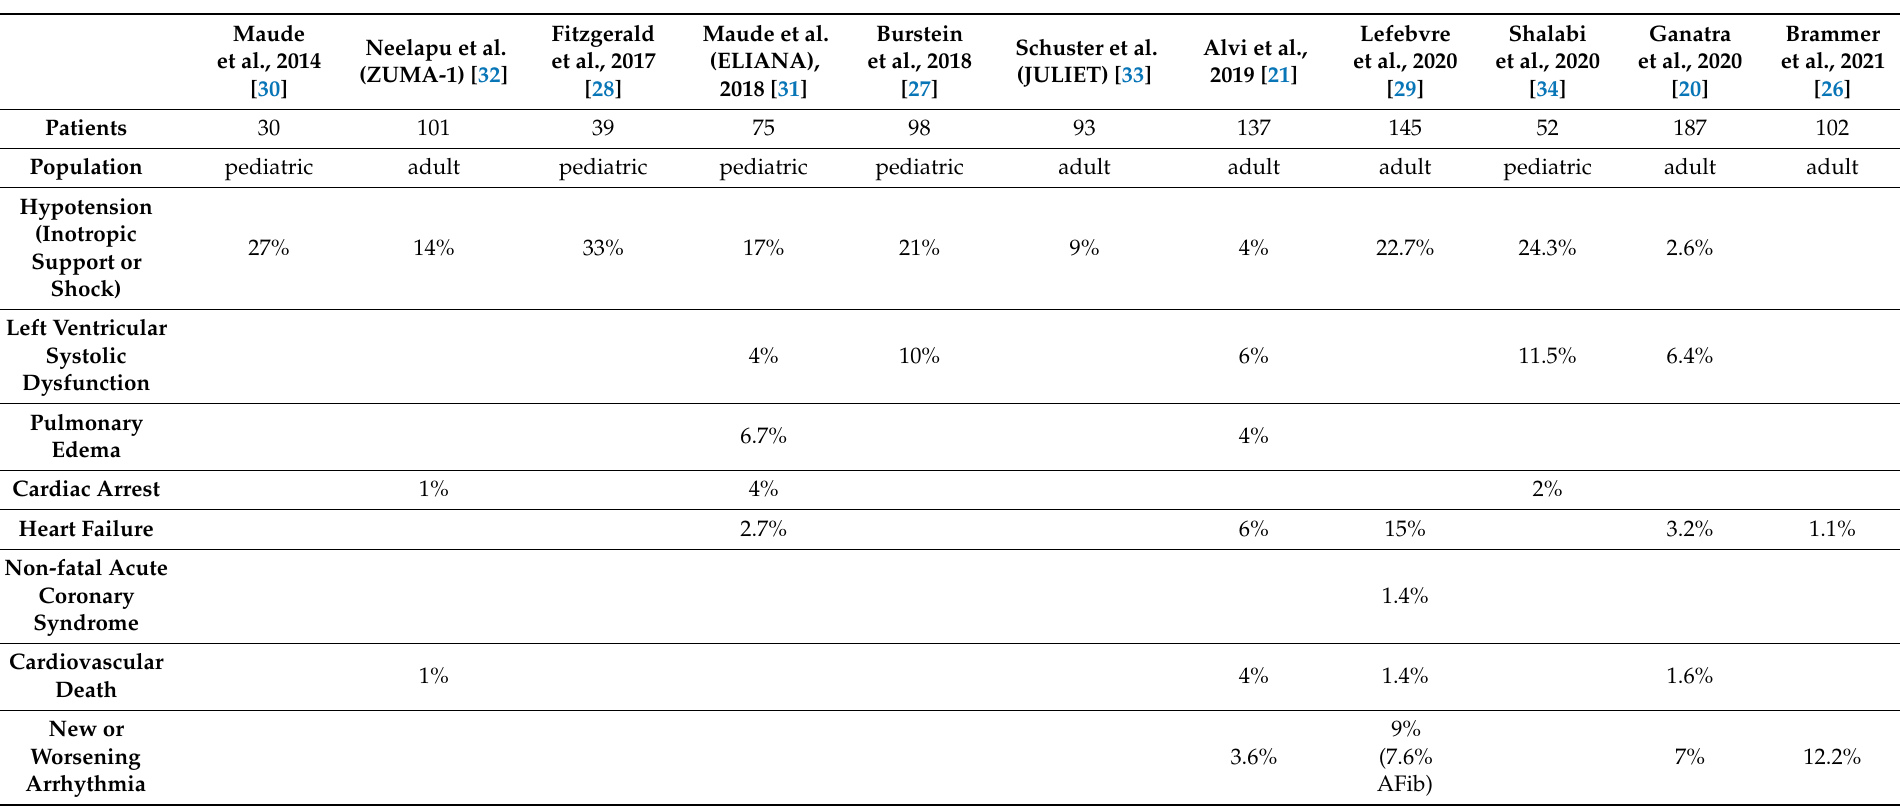
Table 3. Summary of reported cardiotoxicity in adult and pediatric populations associated with chimeric antigen receptor T-Cell